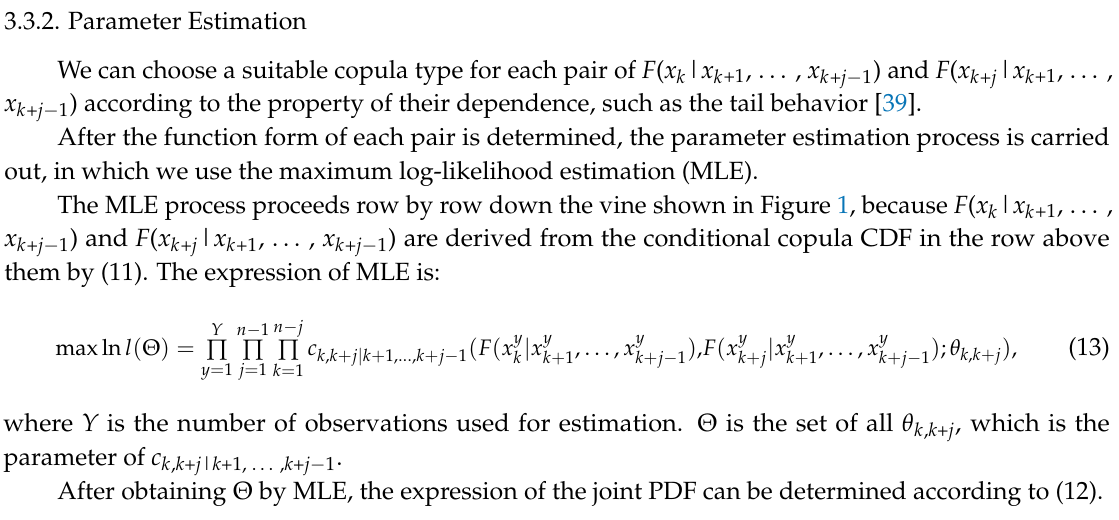
Figure 1. Graphical structure of four-dimensional D-vine copulas.